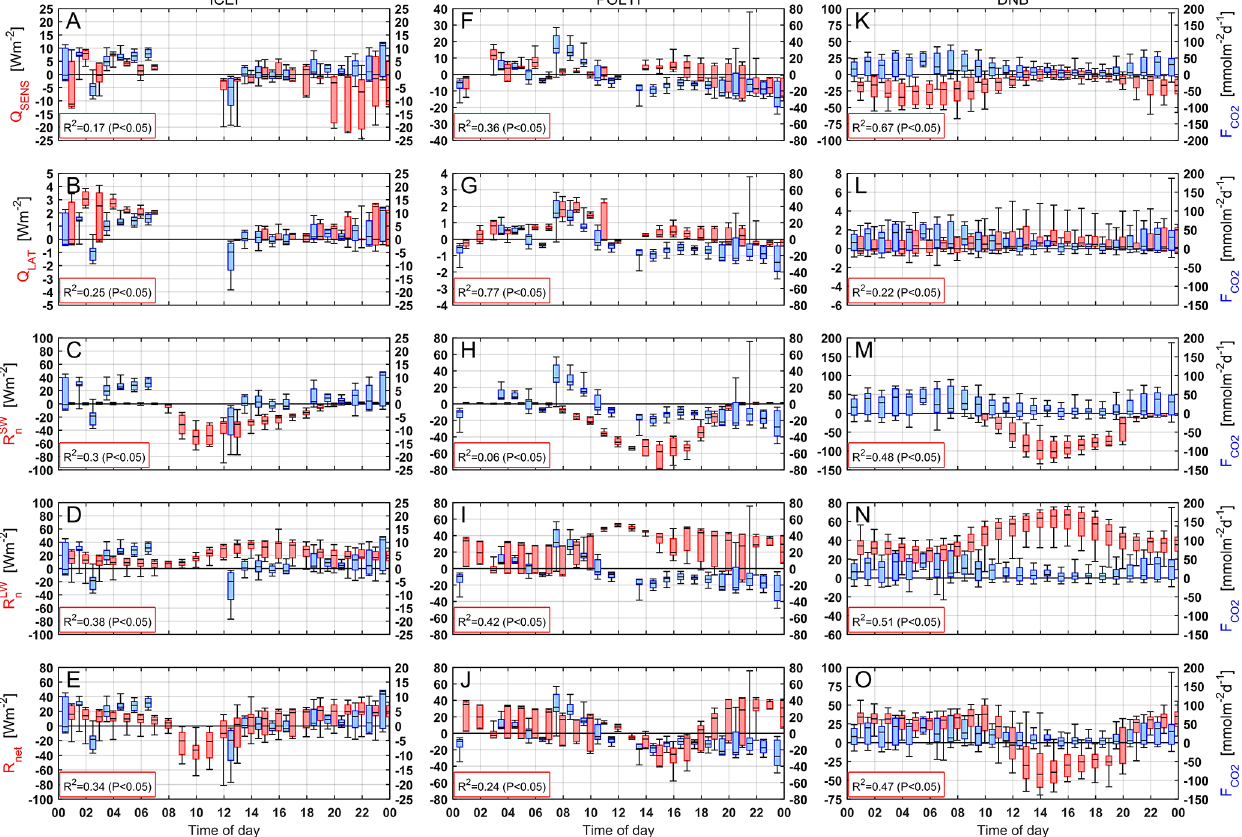
Figure 5. Diurnal patterns of (AFK) sensible heat flux (BGL) latent heat flux (CHM) net shortwave energy (DIN) net long-wave energy and (EJO) net radiative energy (red box plots), shown alongside the diurnal pattern of CO 2 fluxes (blue box plots) for the three experimental sites in question (columns). Box plots are composed of the median (black middle line), the 25–75th percentile (box) and the 9–91st percentile (black whiskers), respectively. Correlations are indicated along with P values in red boxes in the lower-left corner of each graph. In order to account for outliers, the correlations given are the best among four diurnal correlations based on either all data, the 9–91th percentile, the 25–75th percentile or the medians, for which P <